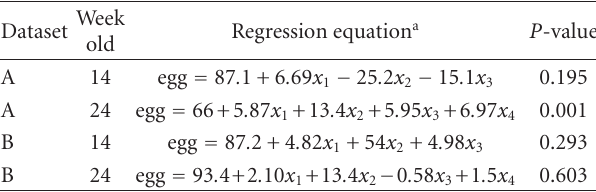
Table 8: First-order multiple linear regression model. Week Regression equation Dataset old